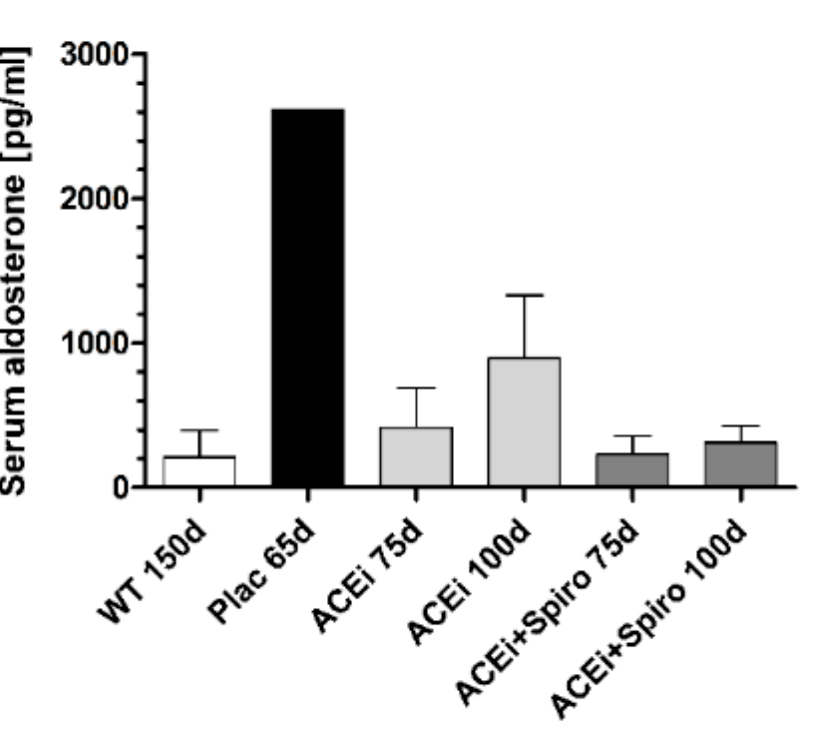
Figure 1. Serum aldosterone levels indicating an aldosterone-escape in Alport mice receiving Angiotensin-converting enzyme inhibitor